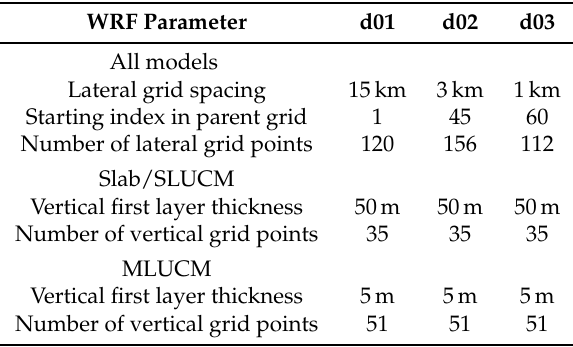
Table 2. Discretization parameters to define the three domains d01, d02 and d03. The vertical layers vary for different urban models, as the Slab and single-layer urban canopy model (SLUCM) models do not resolve the urban canopy, while the multi-layer urban canopy model (MLUCM) does resolve the urban